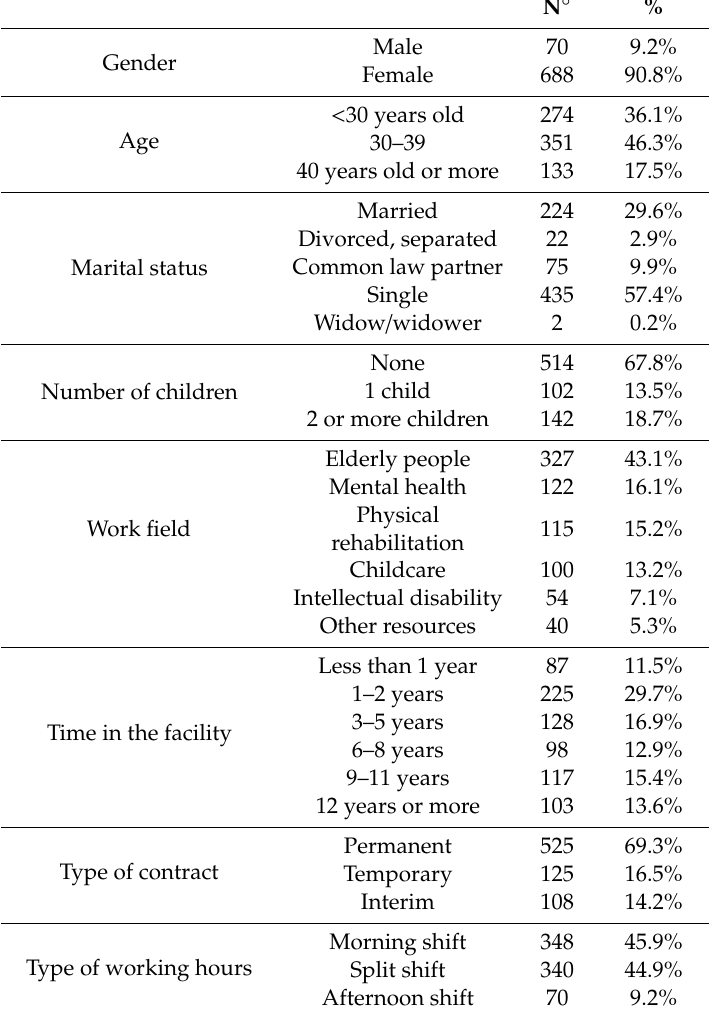
Table 1. Characteristics of the people studied ( n =